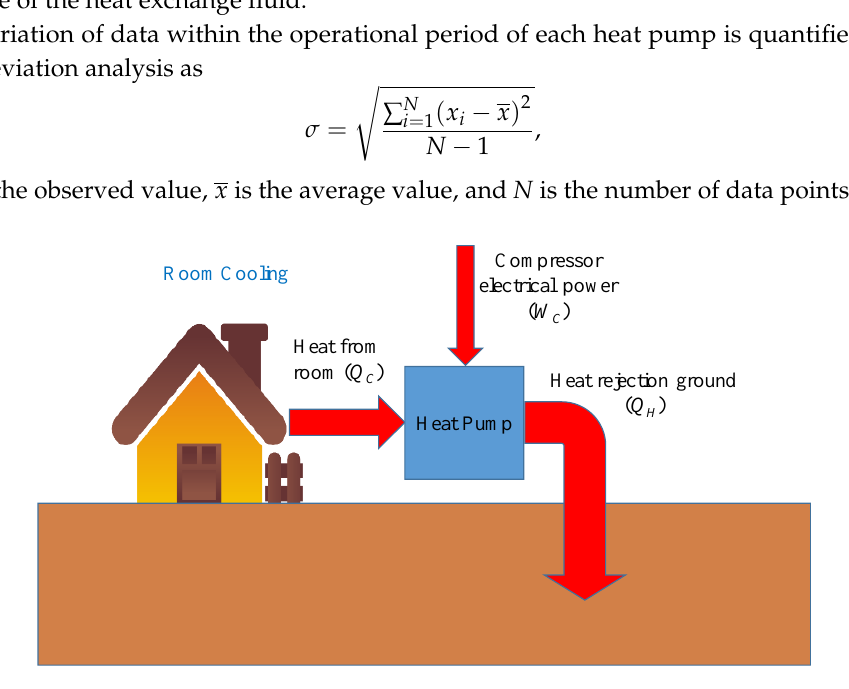
Figure 8. Illustration of energy flow during cooling.